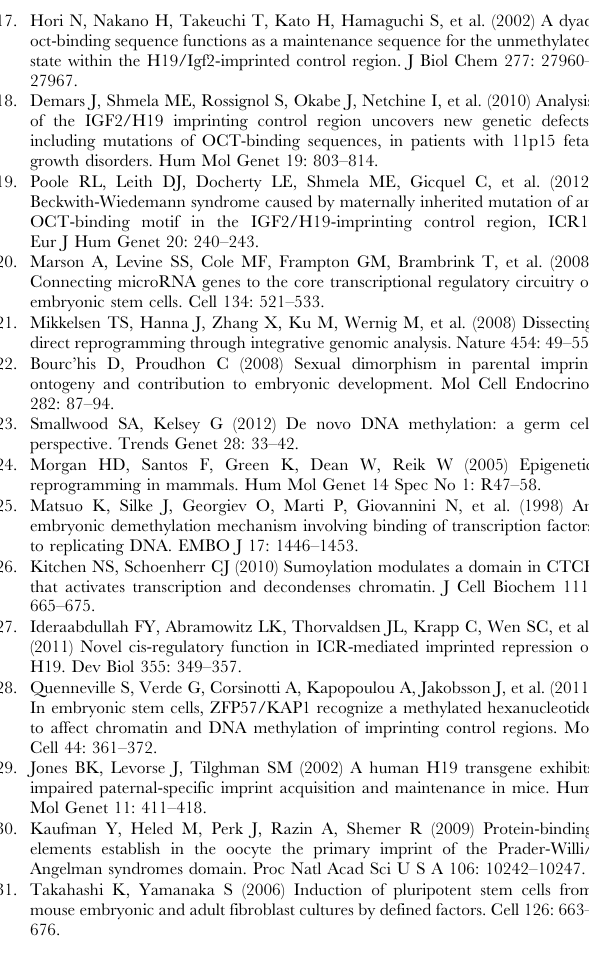
(TIF) Figure S3 Bisulfite analysis of WT and mutant mater- nally transmitted ICRs from neonatal muscle. Bisulfite sequencing was performed on DNA isolated from the leg muscle of two different 4 dpn pups (one each for WT and mutant) resulting from reciprocal crosses of mice possessing the WT cast . and mutant B6 allele. A polymorphism on the WT cast .allele eliminates a single CpG located between the two octamer sites. (TIF) Table S1 EMSA oligonucleotides.